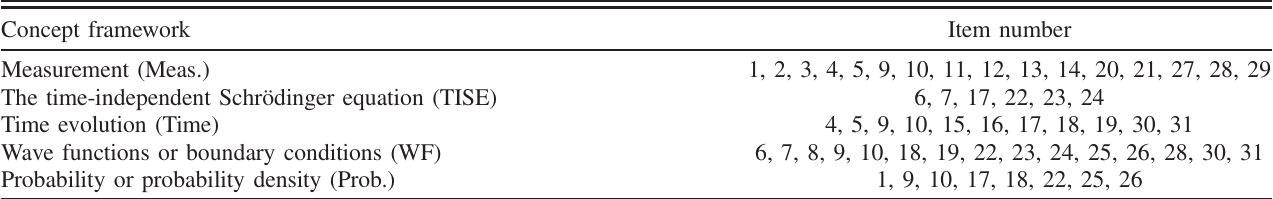
TABLE I. A classification of the QMCA concept framework with the item numbers in which they appear. Concept framework Item number Measurement